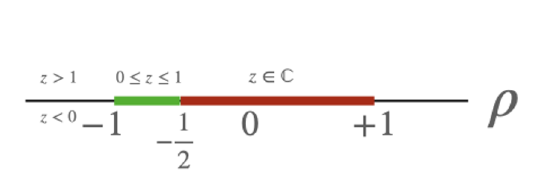
Figure 1. The ρ -variable. We have marked the range of interest. Green indicates physical region while red indicates unphysical